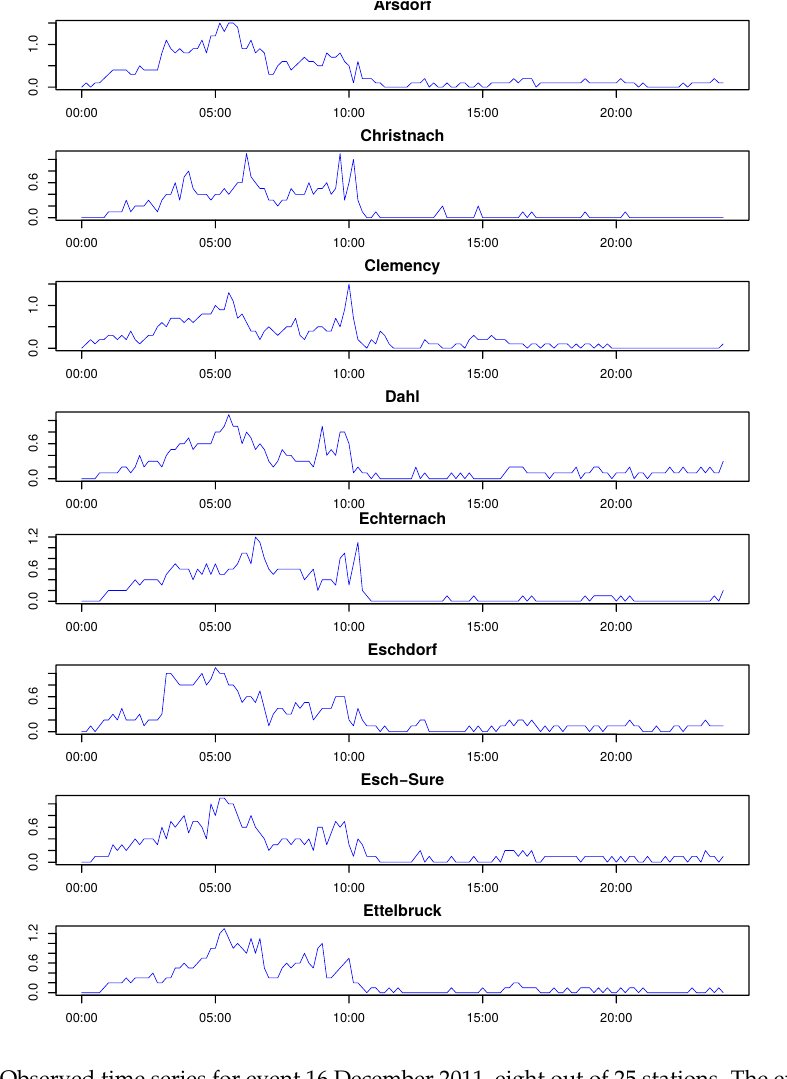
16 Figure 5. Observed time series for event 16 December 2011, eight out of 25 stations. The experimental variogram was calculated in the interval from 12:00 a.m. to 10:00 a.m. including the 25